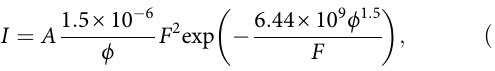
Fig. 3 Field electron emission characteristics. a The dependence of the total emission current (red) and probe current (blue) on extraction voltage for a tip that has a radius of 400 nm. b The angular current density-voltage trace from the Ni tip with a tip radius of 700 nm before coating with graphene (orange), and after coating with graphene (violet). c The F-N plot with and without the graphene coating